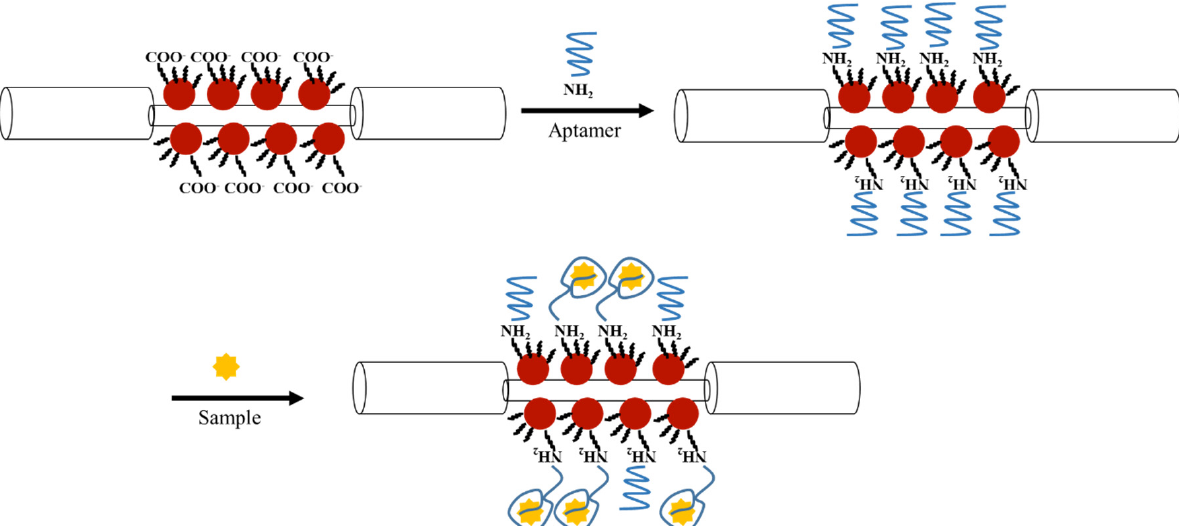
Figure 2. Schematic illustration of the reactions in bioconjugation of aptamer and the binding between the immobilized aptamer on AuNPs and the N-protein in sample.